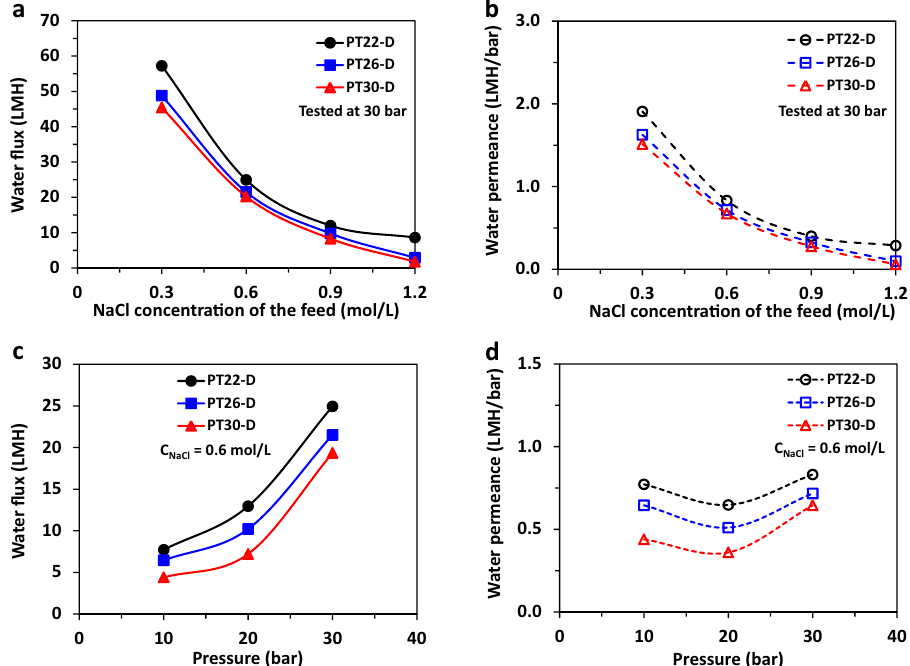
Fig. 8 The OARO performances of the optimal PES-TFC hollow fi ber membranes. a , b The effects of salt (NaCl) concentration on water fl ux and water permeance. The NaCl concentration was the same for the feeds in the lumen and shell sides of hollow fi bers, and the operating pressure was 30 bar. c , d The effects of operating pressure on water fl ux and water permeance. The feed and sweep streams were 1.2 mol/L NaCl solutions. LMH/bar. The water fl ux of the PT30-D membrane decreases osmotic pressure in the feed solution from 14.7 to 58.7 bar as the from 45.4 to 1.7 LMH while its water permeability decreases from NaCl concentration rises from 0.3 to 1.2 mol/L; (2) the ICP and 1.51 to 0.06 LMH/bar. Such decreases in water fl ux and ECP reduce the effective driving force across the membrane. On permeance could be ascribed to two reasons: (1) the increase of the inner surface (or lumen side) of the TFC hollow fi ber, the salts NATURE COMMUNICATIONS| (2021) 12:2338